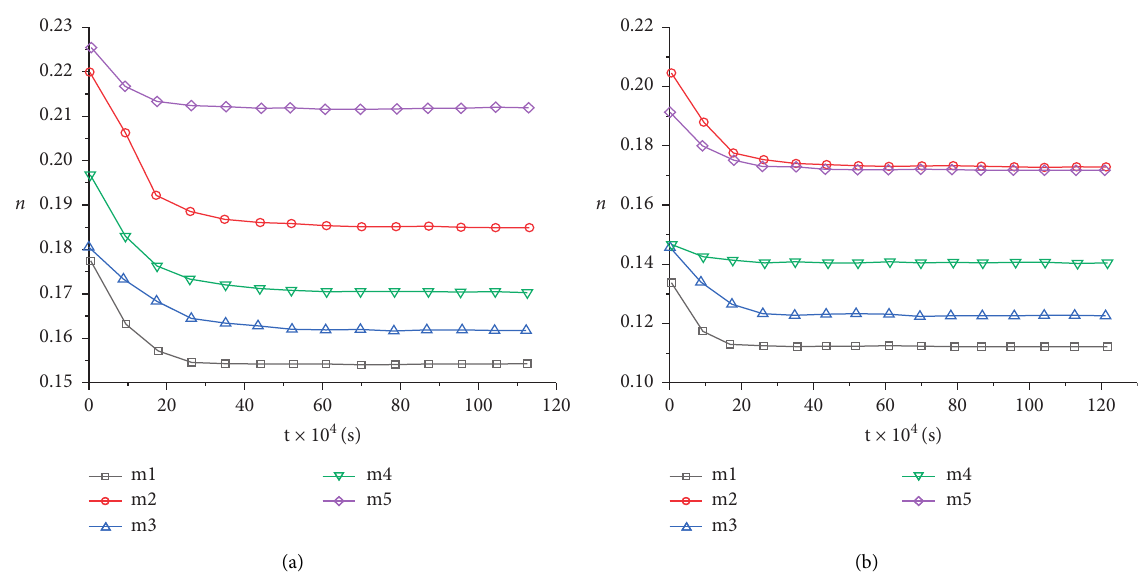
Figure 5: Influence of grain size on the porosity of fragmentized coals. (a) 8MPa. (b) 12